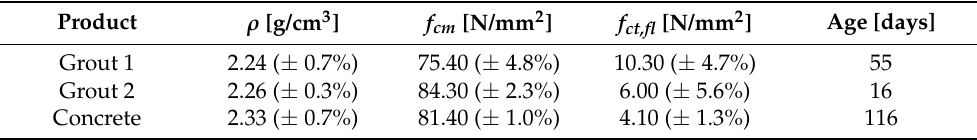
Table 6. Mechanical properties of mortar and concrete.